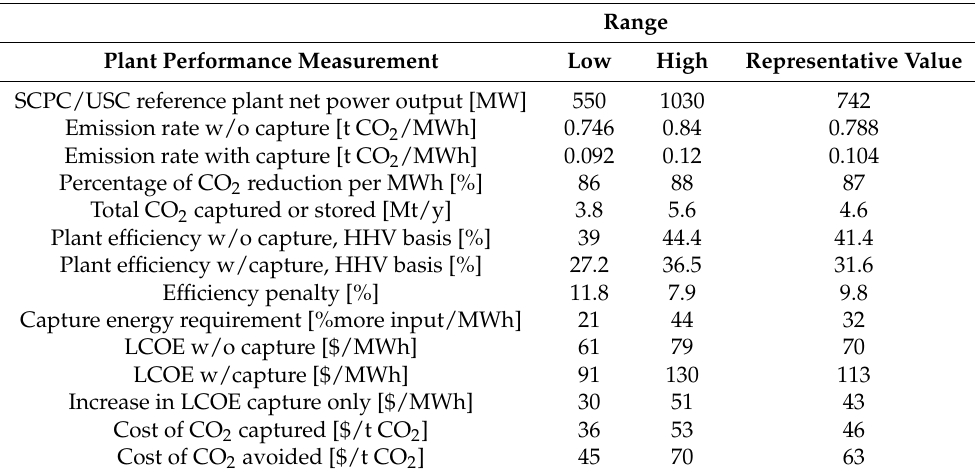
Table 3. Current performance and cost estimates for post-combustion capture at SCPC power plant (values in 2013$)